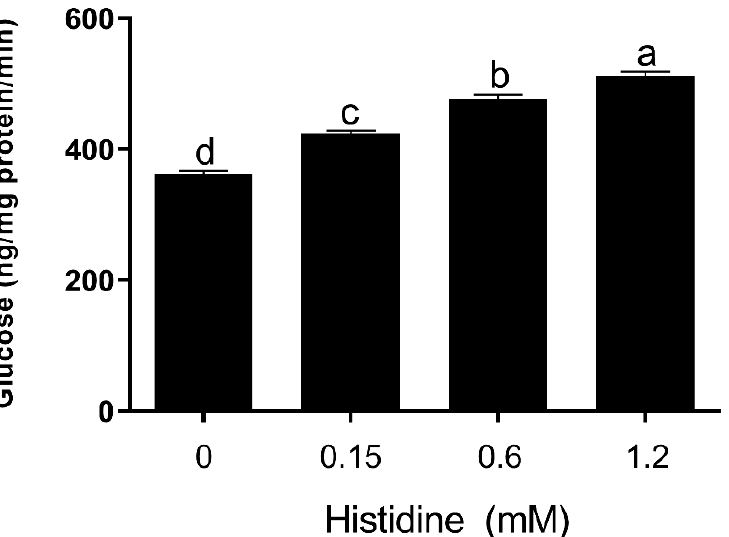
Figure 3. The rates of hepatic glucose output in the absence or presence of different concentrations of His. Data are presented as the means ± SEM ( n = 6). Means at the different concentration of His with different letters (a–d) differ significantly for treatment effect.